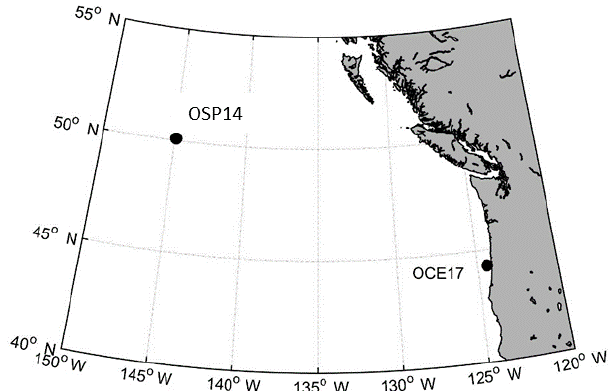
Figure 2. Map of the subarctic NE Pacific showing location of OSP14, in offshore iron-limited waters, and OCE17, a coastal up- welling